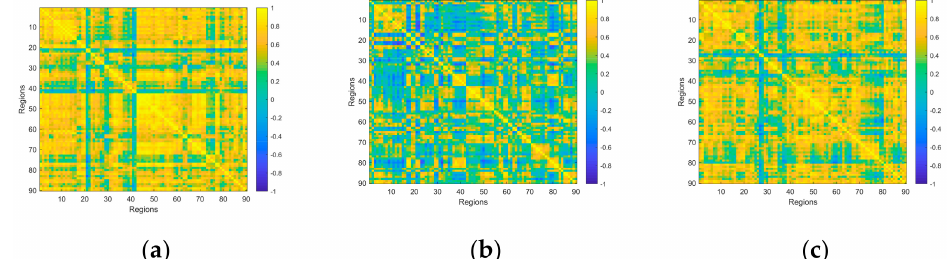
Figure 2. The FNC matrix of three tasks performed by a subject. ( a ) The FNC matrix of a single target tracking task with word from word-scene pairs. ( b ) The FNC matrix of a multiple target tracking task with lure word. ( c ) The FNC matrix of a multiple target tracking task with word from word-scene